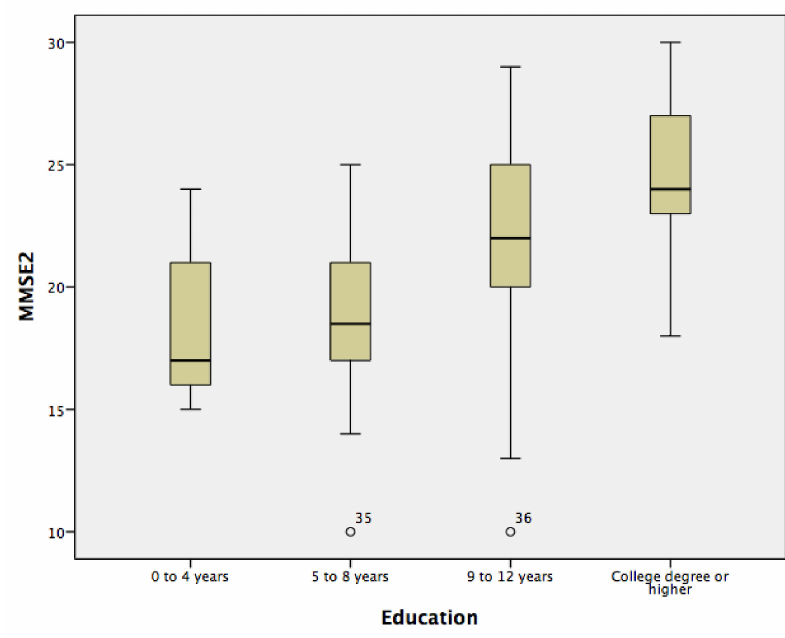
Figure 2. The distribution of MMSE-2 scores across years of education. Bonferroni post hoc comparisons examined differences between groups ( p <